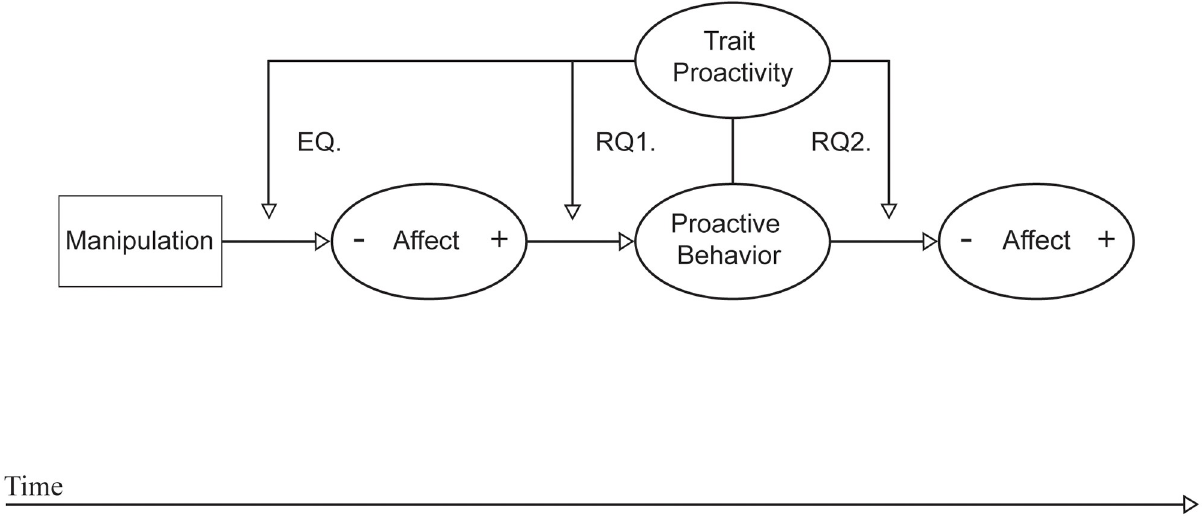
Fig 1. Conceptual